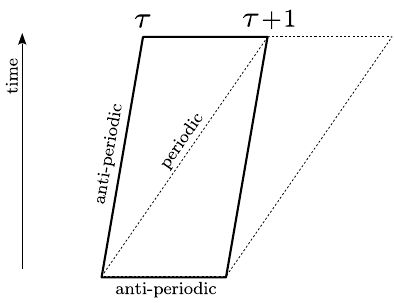
Figure 10 . The fermion boundary conditions used to de(cid:12)ne the partition function. They are invari- ant under the S -transformation. However, the T -transformation changes the temporal boundary conditions and hence the partition function. It also destroys the S -invariance as the spatial and temporal boundary conditions no longer